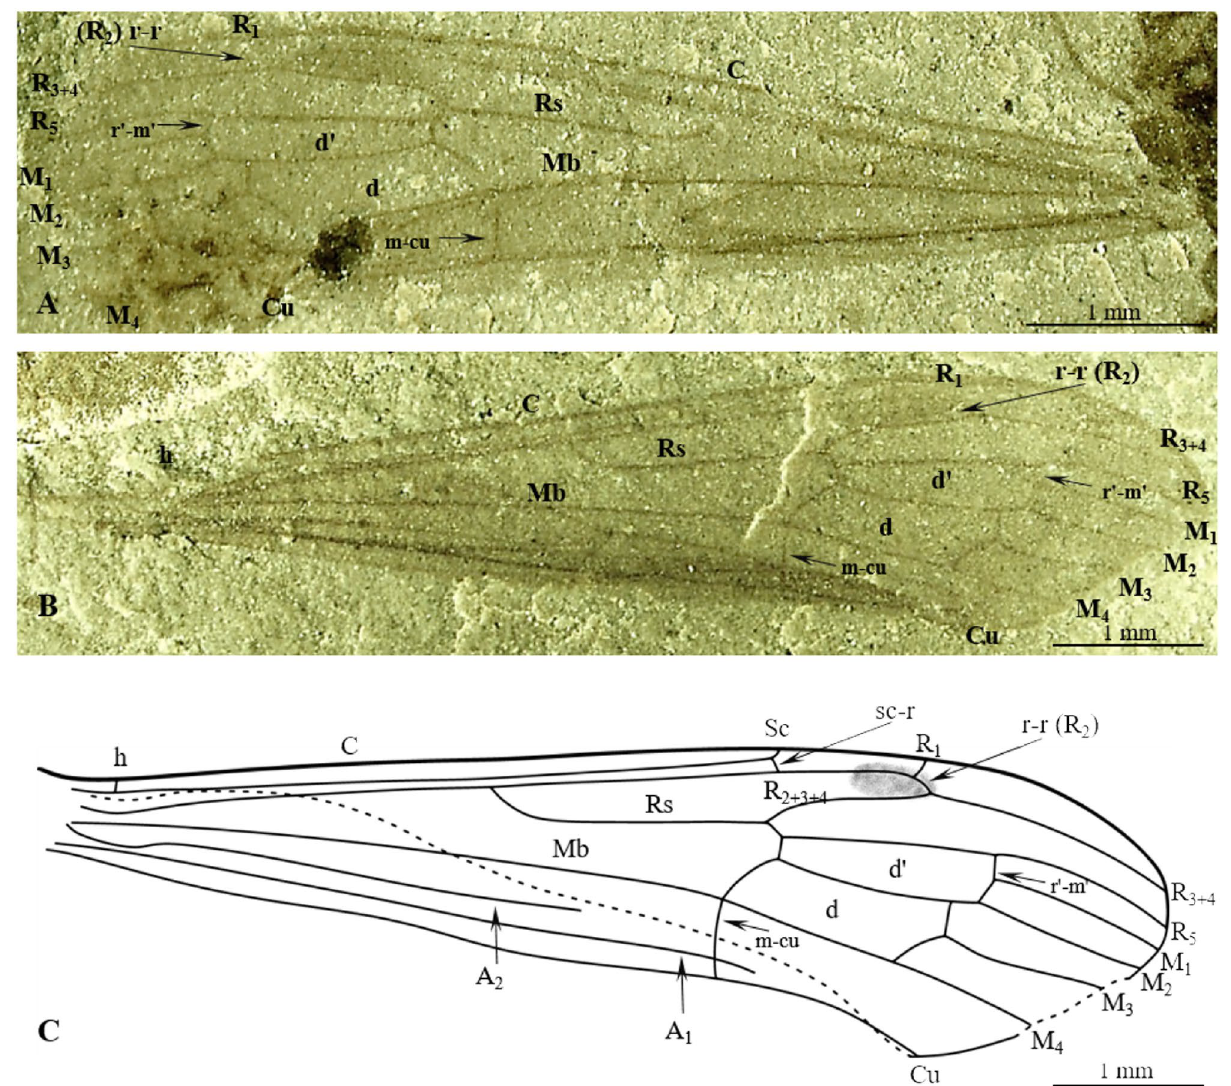
Figure 3. Cyttaromyia gelhausi sp. nov.: ( A ) No. MNHN.F.A71341 (18a, male) (holotype), wing; ( B ), C. No. MNHN.F.A71341 (18c, female) (additional material): ( B ) wing; ( C ) wing,